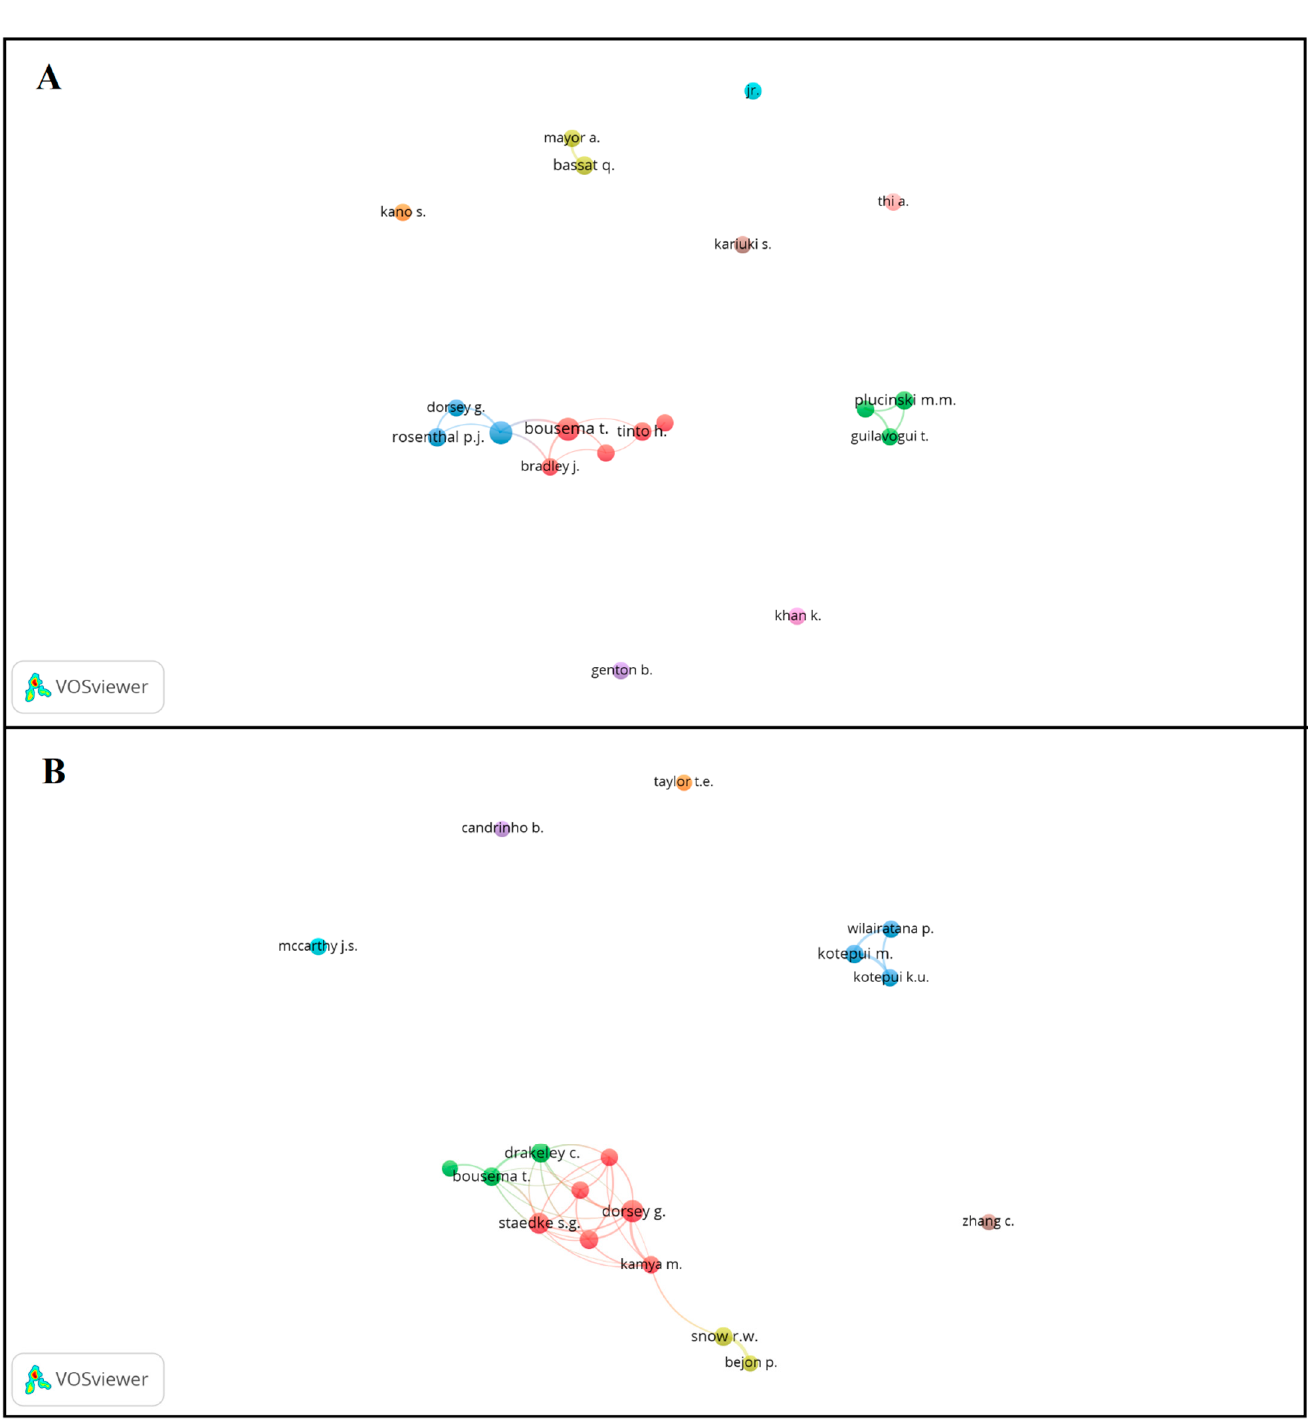
Figure 1. Authors that contributed to malaria publications. ( A ) before the COVID - 19 pandemic, ( B ) during the COVID - 19 pandemic.